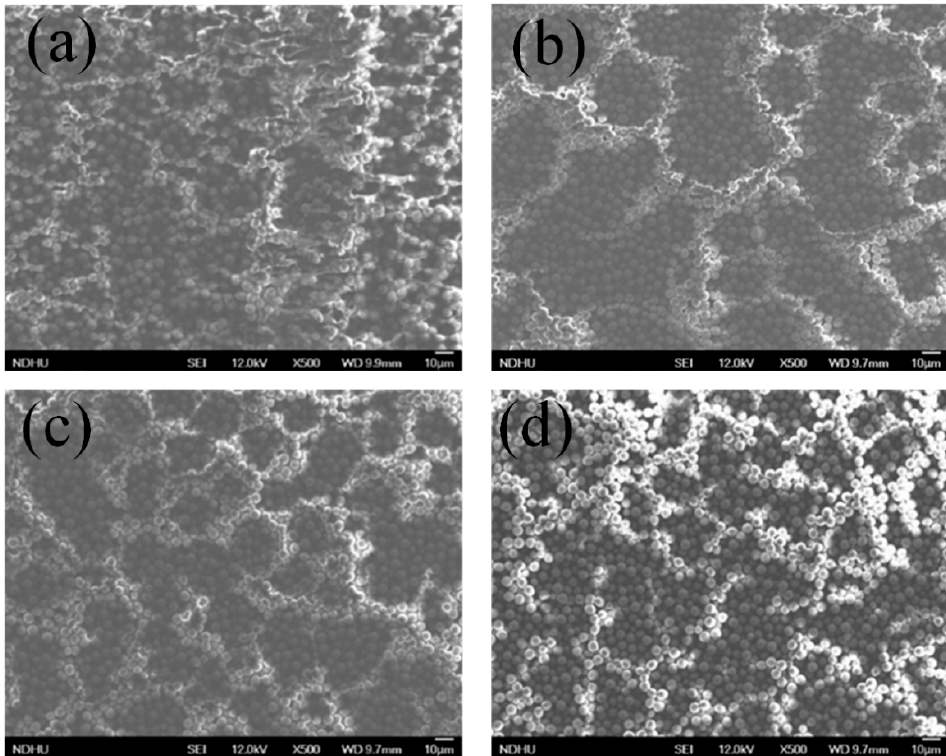
Figure 3. Top-view SEM photograph of the fabricated SiO 2 –PMMA composite film for the SiO 2 particle weight percent concentrations of ( a ) 15 wt%, ( b ) 20 wt%, ( c ) 25 wt% and ( d ) 35 wt%.